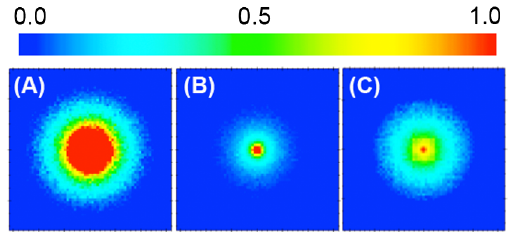
FIG. 7. Illustration of the generation of film response to pro- tons from simulated data. (A) Proton density in a simulated layer of film. (B) Dose deposited from the protons in the left image. (C) Final result after weighting the deposited dose with the optical density response of the film.